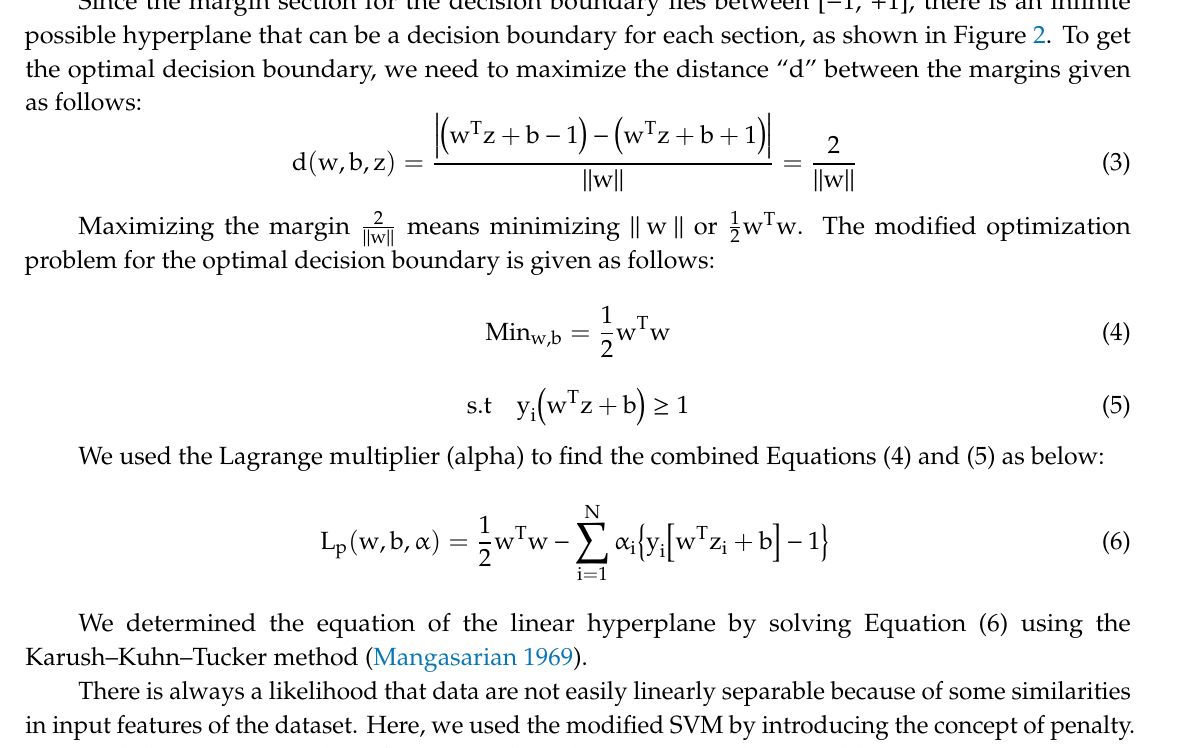
Figure 2. Linear decision boundary with two explanatory variables x 1 and x 2 .